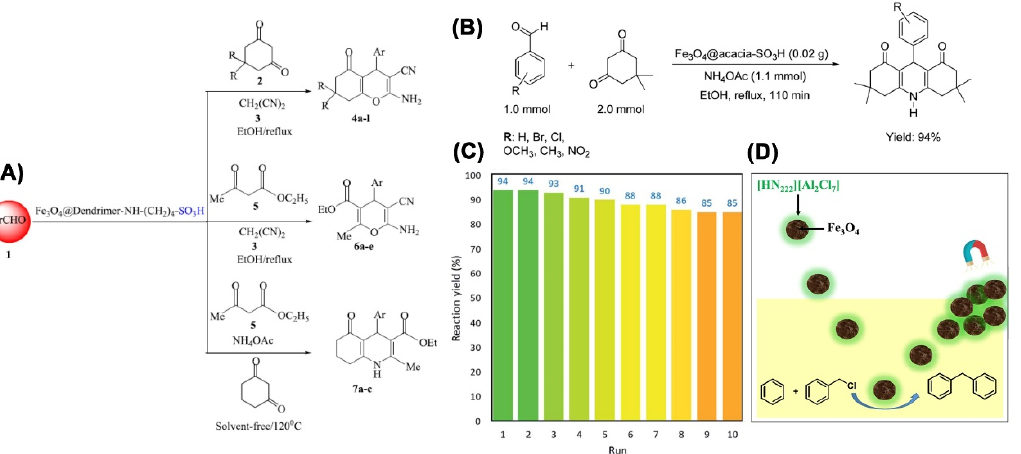
Figure 13. ( A ) One-pot synthesis of polyfunctionalized pyrans and polyhydroquinolines [136], Copyright 2019 Elsevier. ( B ) Organic synthesis reaction of the 9-phenyl hexahydroacridine derivatives catalyzed by the Fe 3 O 4 @acacia–SO 3 H nanocatalyst and ( C ) recycling diagram [137], Copyright 2020 Elsevier. ( D ) Schematic illustration of the application of ILs grafted Fe 3 O 4 NP in alkylation of benzene with benzyl chloride reaction [35], Copyright 2021 American Chemical